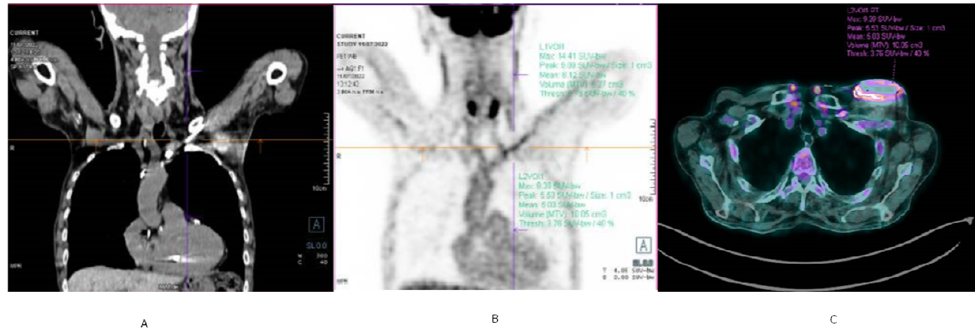
Figure 3. Transesophageal echocardiogram, 5 chamber view, showing a vegetation (19 × 6 mm) ad- herent to pacemaker’s ventricular lead in 2D (panel ( A ), white arrow) and 3D (panel ( B )). The same vegetation is also shown in right ventricular inflow-outflow view (and its orthogonal plane-bicaval view) in 2D (panel ( C )) and in 3D (panel ( D )). RV: right ventricle; RA: right atrium.